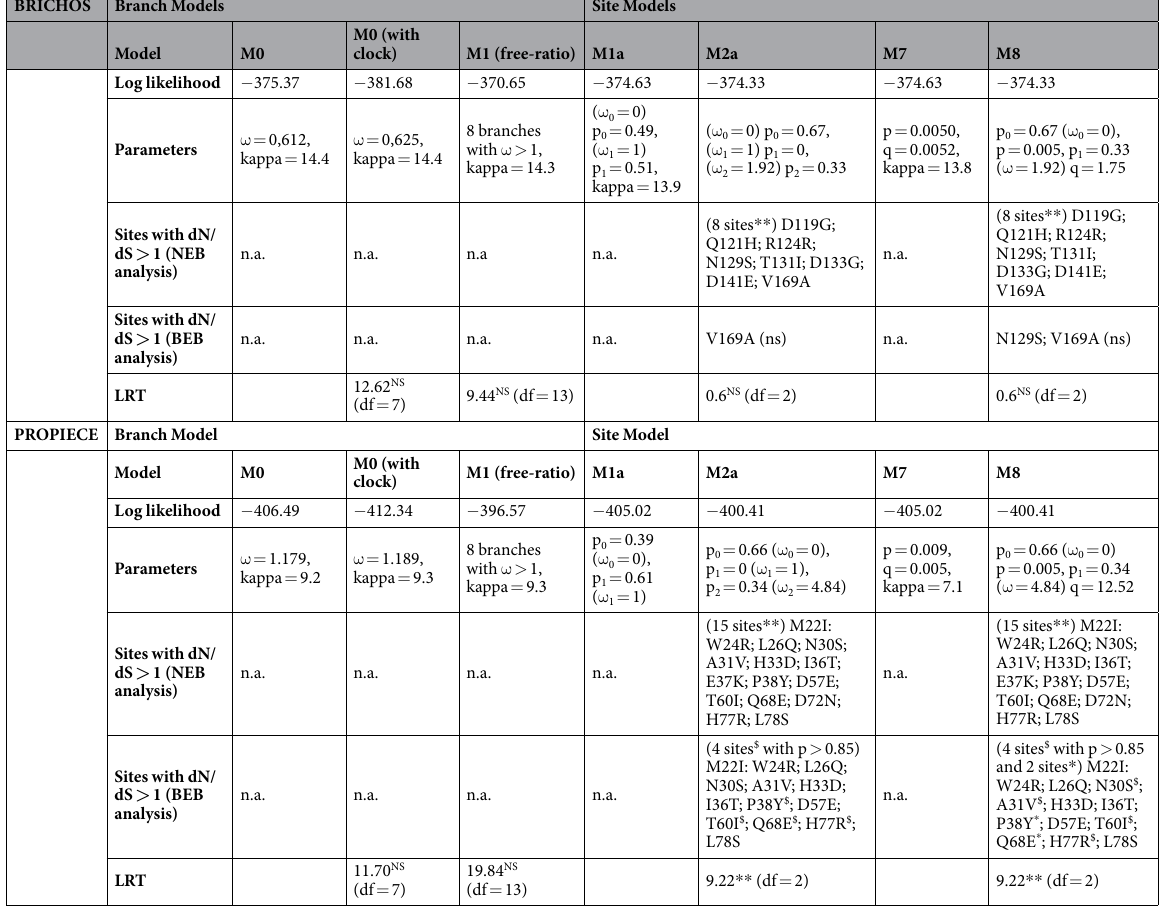
first duplication event, with some early duplications subsequently kept in populations and now displaying their own pattern of accumulated mutations (0.052 substitution per site). Mutation and recombination are two major evolutionary mechanisms driving genetic diversity and likely to promote an adaptive response to cope with biotic interactions, but their relative contribution varies greatly between genes and organisms 57 . In the specific case of preproalvinellacin, the main positive outcome of intergenic recombination would be the spread of positively selected mutations between duplicates leading to the observed patterns of “shared polymorphism” in the propiece and BRICHOS domains between paralogs. Although we cannot rule out the hypothesis of retention of an ances- tral polymorphism due to balancing selection occurring within duplicated genes, a more likely explanation would be that the observed mutation reversals are the result of a transfer of newly gained positive mutations from one duplicated gene to another via gene conversion or unequal crossing-over as previously proposed in newly dupli- cated genes in tandem 58 . Balancing selection within duplicates would have led to high π a / π s ratios around the non-synonymous shared polymorphisms, a situation not recorded here.